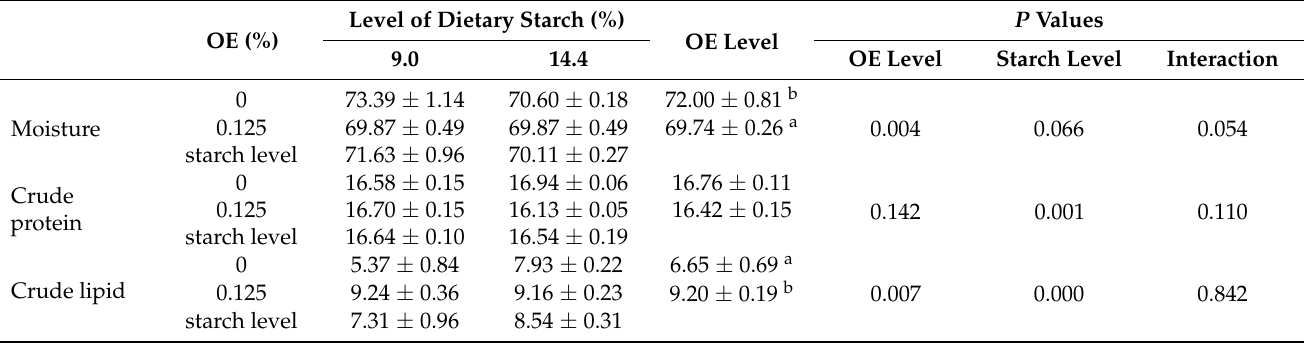
Table 5. Effects of experimental diets on the composition of the whole body in largemouth